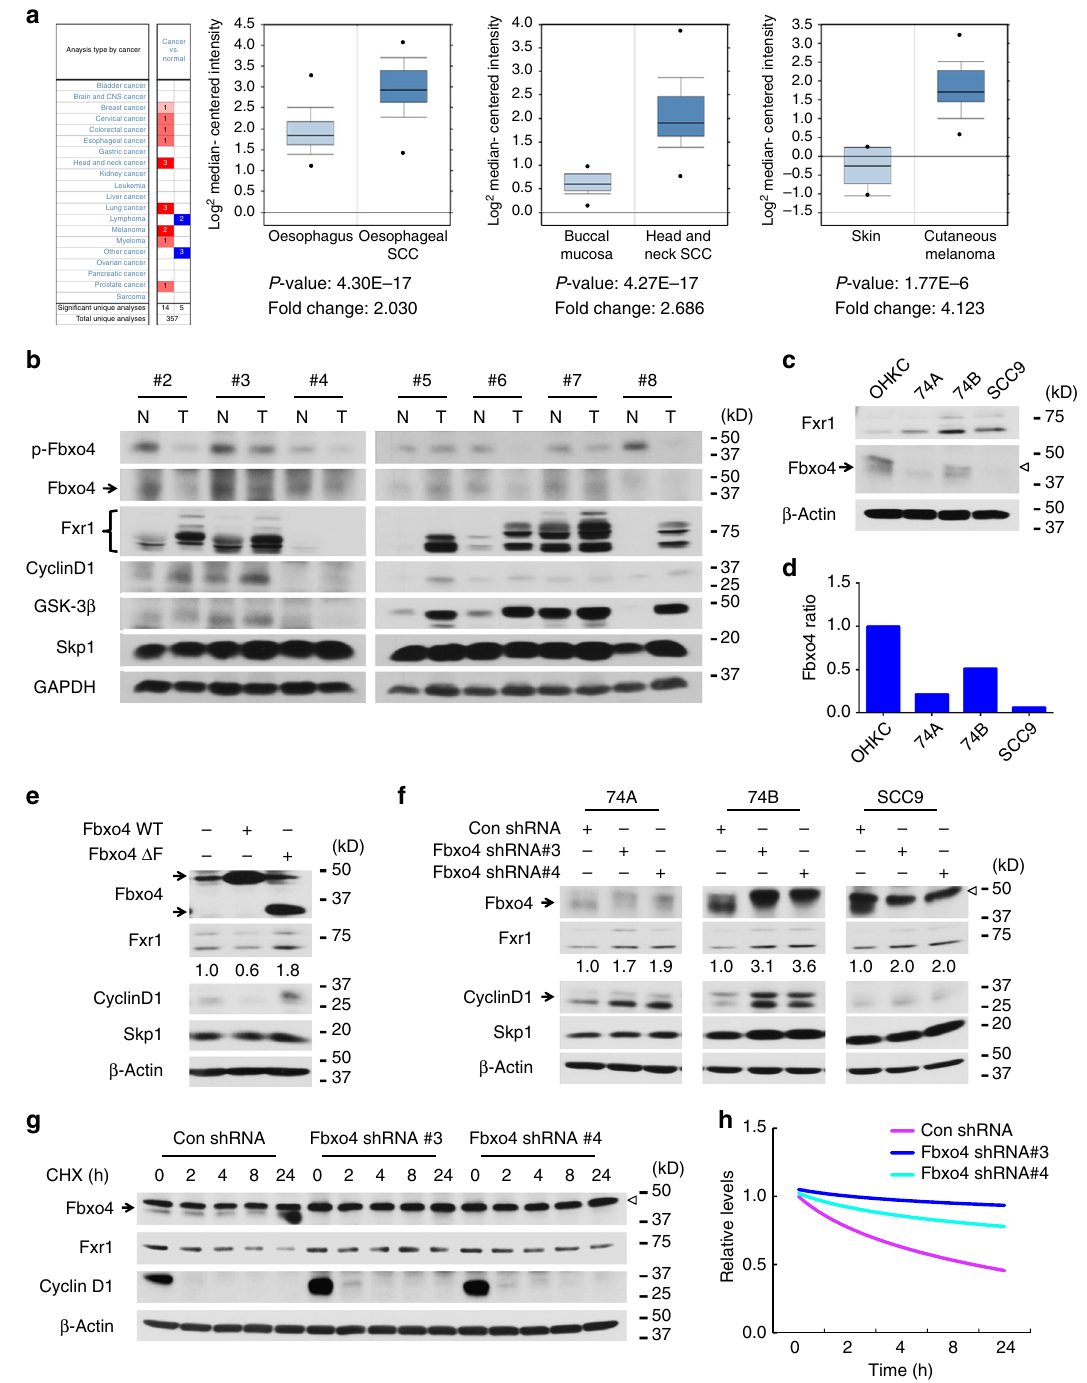
Fig. 3 Genetic manipulation of Fbxo4 alters Fxr1 expression in HNSCC cells. a , b Oncomine analysis reveals elevated Fxr1 in human cancers ( a ) and a reverse correlation of Fbxo4 expression with Fxr1 in human HNSCC tissues and normal counterparts ( b ). All the data represent mean ± s.d. and were analysed by Student ’ s t test. Oncomine Box-and-Whisker plots: median values are shown as horizontal bars; the upper and lower part of the box show the 75th percentile and the 25th percentile, respectively; the upper and lower part of the bar show the 90th percentile and the 10th percentile, respectively; the points show outlier values. c Comparison of Fxr1 and Fbxo4 levels in OHKC and human HNSCC cells. Empty triangle indicates non-speci fi c band observed in some human cell lines. d Quanti fi cation of Fbxo4 bands shown in c , normalised to β -Actin. e WT but not Fbxo4 Δ F suppresses Fxr1 expression in SCC9 cells. The numbers below Fxr1 bands indicate the band quanti fi cation. f Fbxo4 knockdown triggers increased Fxr1 in HNSCC cells. Arrow indicates Fbxo4; empty triangle indicates nonspeci fi c band. The numbers below Fxr1 bands indicate the band quanti fi cation. g Cycloheximide chase of Fxr1 levels in 74B cells following Fbxo4 knockdown. Arrow indicates Fbxo4; empty triangle indicates nonspeci fi c band. h Quanti fi cation of Fxr1 turnover from